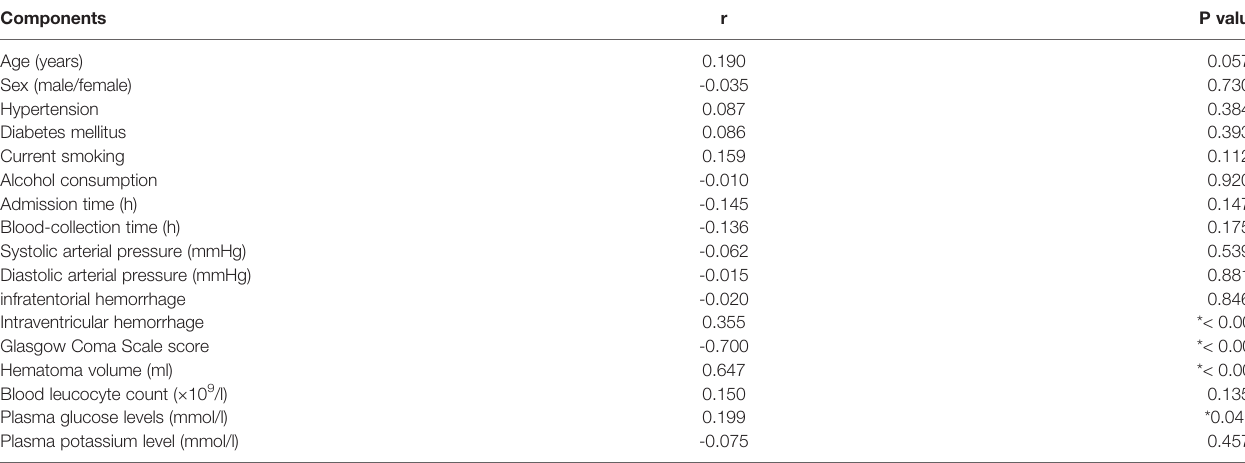
TABLE 2 | Bivariate correlation analysis between plasma C1q levels and other variables in 101 intracerebral hemorrhage patients.